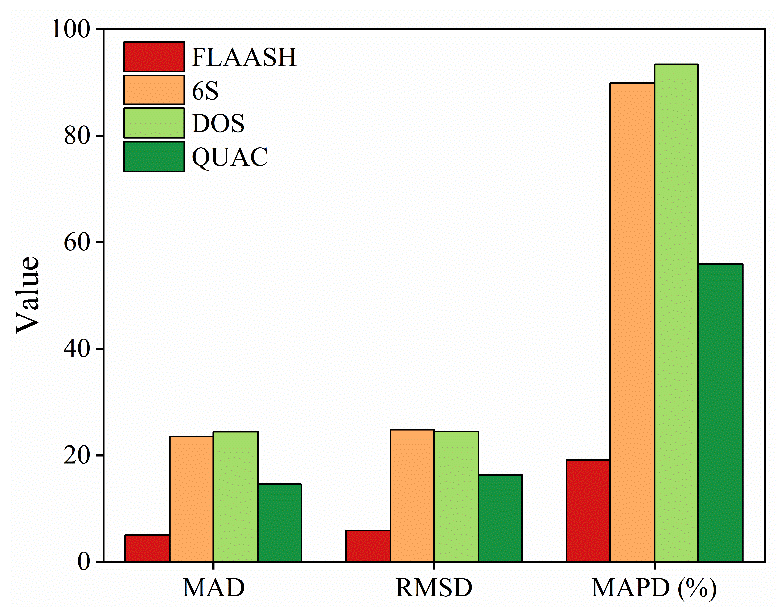
Figure 5. Accuracy of four atmospheric correction algorithms on Landsat-8 OLI.